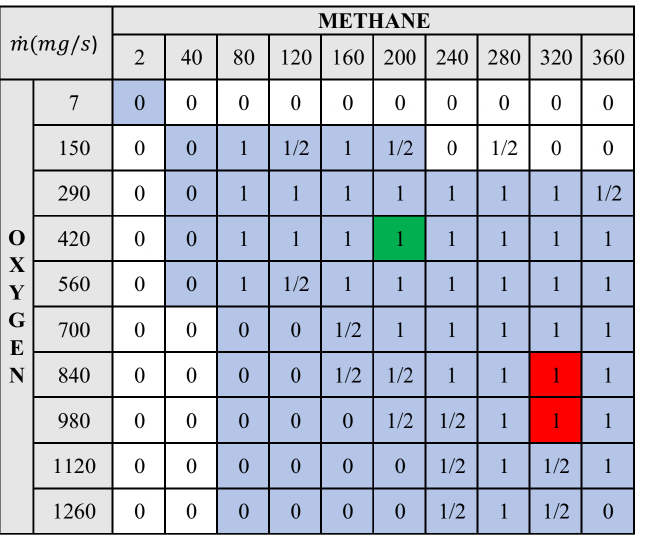
Figure 6. Occurrence of ignition inside the igniter’s combustion chamber with in terms of the propellants mass flow